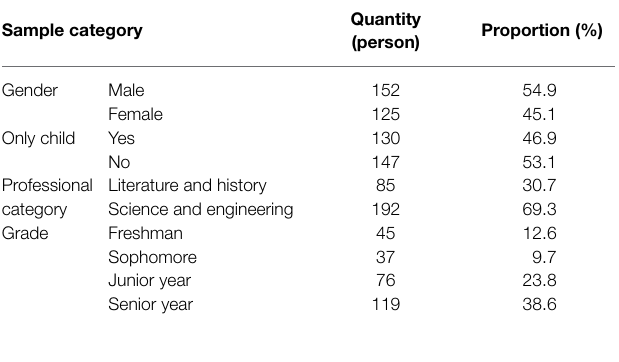
TABLE 1 | Statistical table of the basic situation of the surveyed individuals. Sample category